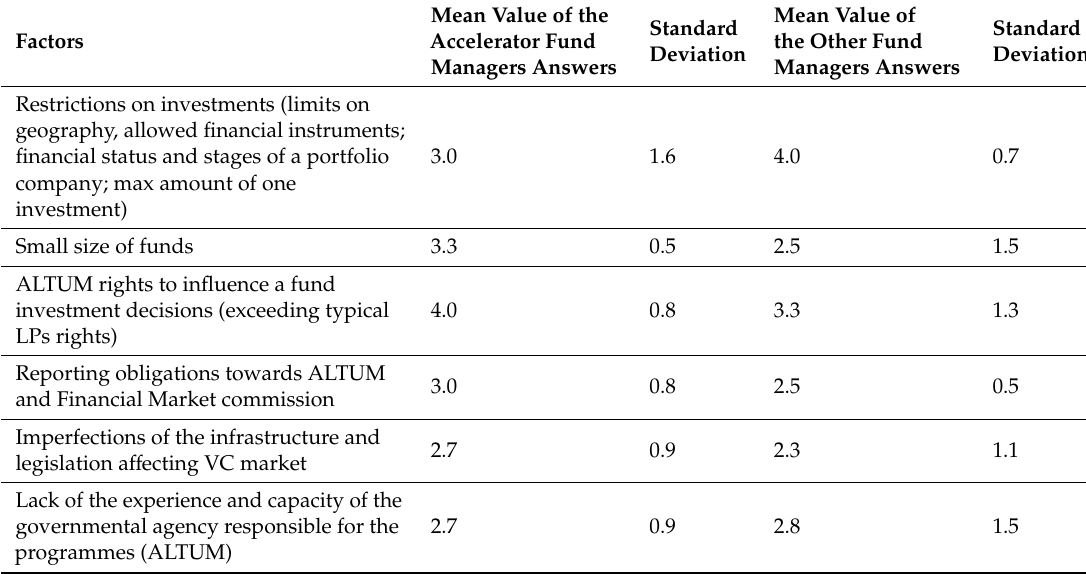
Table 5. Impact of limiting factors on the fund managers activities in 2014–2020 planning